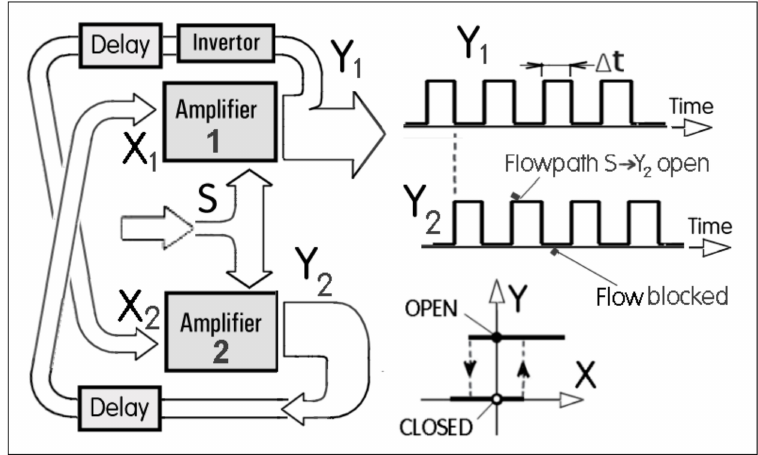
Figure 13. Schematic presentation of the “flip-flop” pair of amplifiers blocking one another. A typical present-day amplifier shown in Figure 6 is actually an integrated version of this